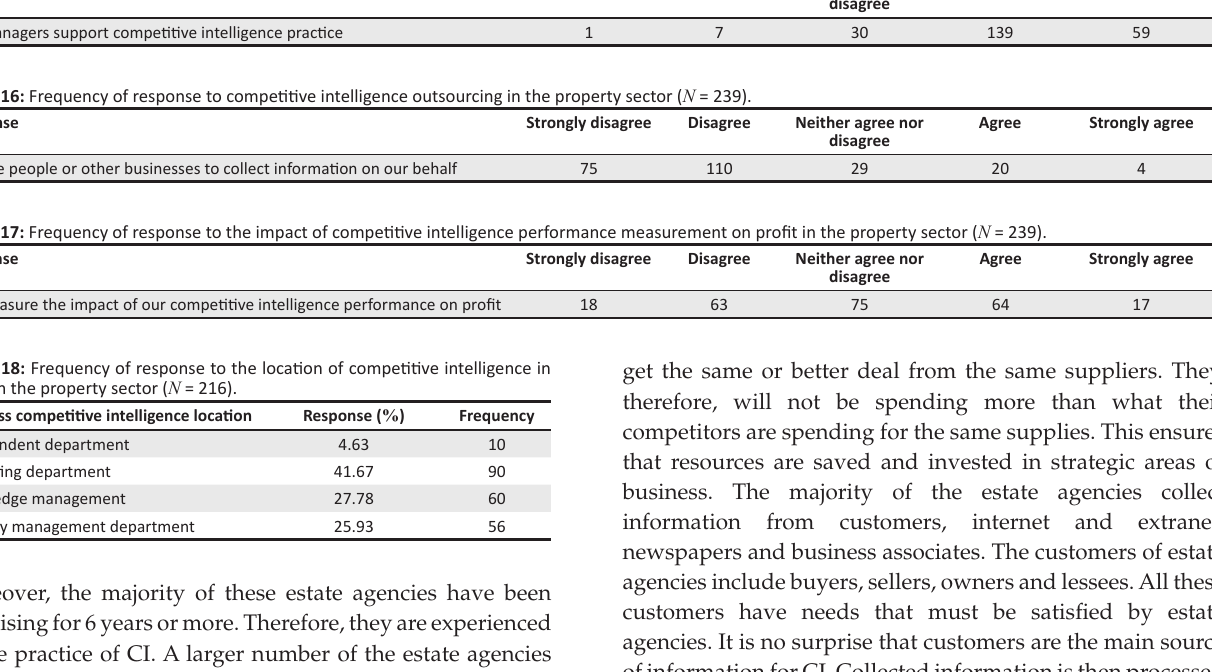
TABLE 15: Frequency of response to management support of competitive intelligence practice in the property sector ( N = 239). Response